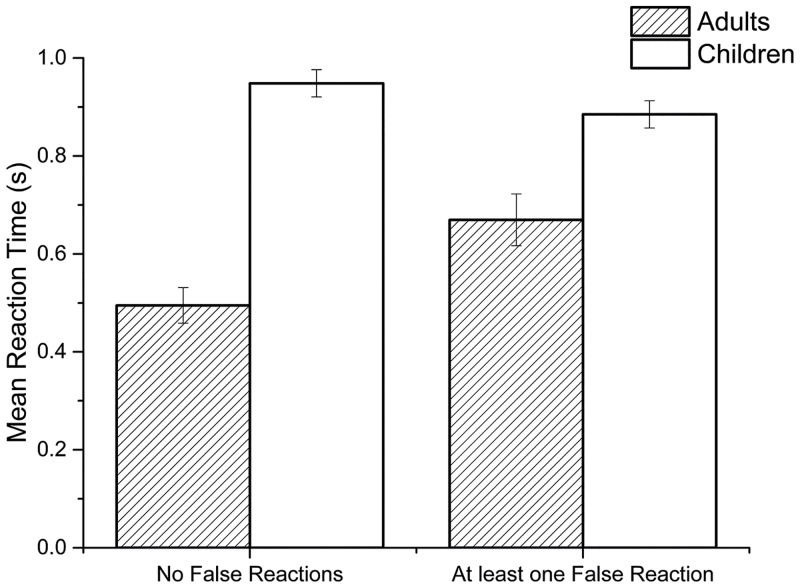
Bar graph illustrating the significant interaction between age-group and false reaction category for mean reaction time in Experiment 2.Error bars represent 95% confidence intervals.